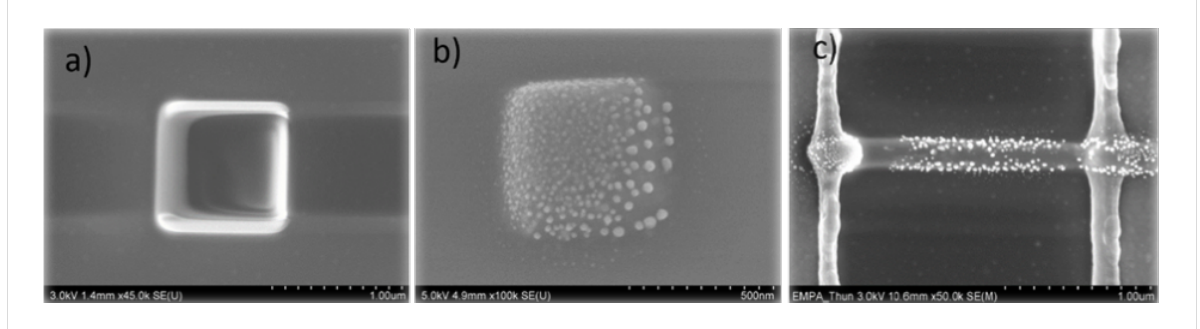
Figure 4: Post-growth laser annealing of FEBID deposits from Cu(hfac) 2 . SEM top view images of a) as-deposited square, b) Cu nanocrystals forming due to laser annealing at a power of 13.6 W over 1 min, c) laser-annealed FEBID line between two gold electrodes.